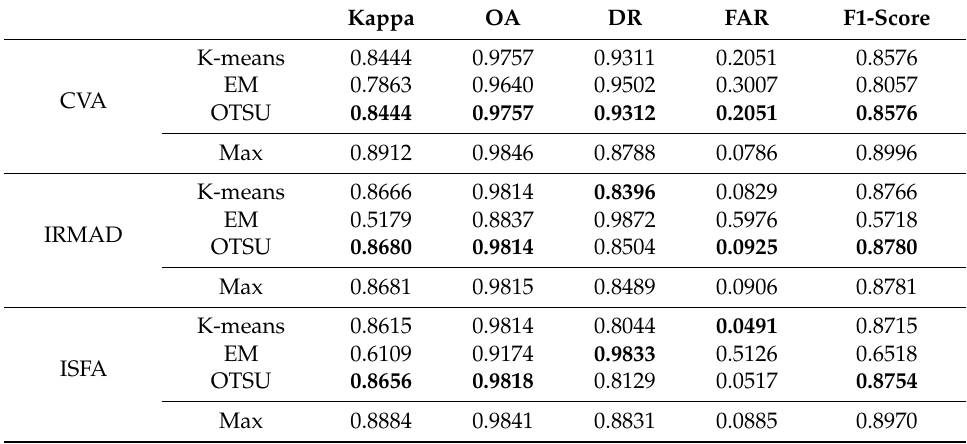
Table 1. Quantitative evaluation of different thresholding methods in test dataset